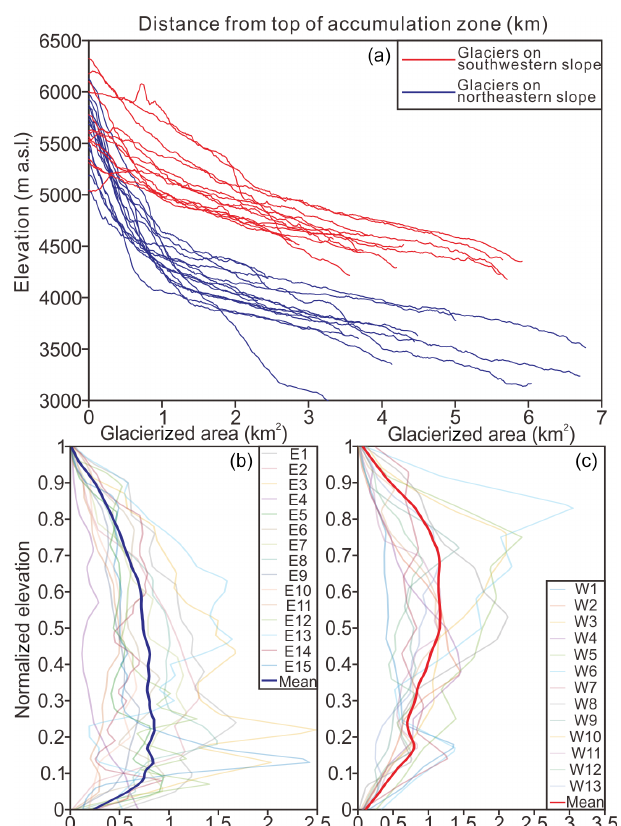
Figure 11. (a) Surface elevation profiles of studied glaciers ex- tracted from ASTER GDEM, (b) hypsometry curves of northeastern glaciers, and (c) hypsometry curves of southwestern